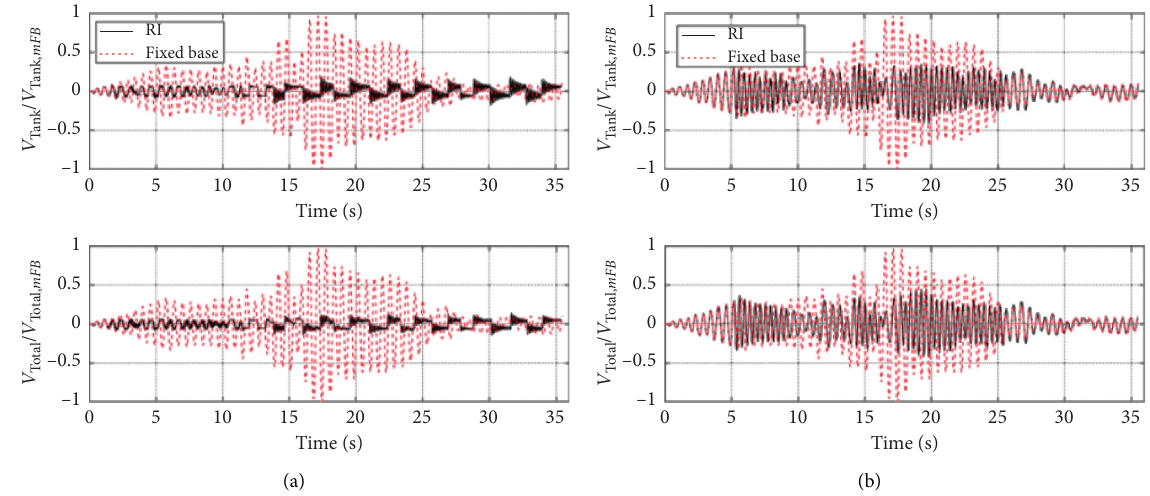
Figure 15: Normalized tank-base ( V C2